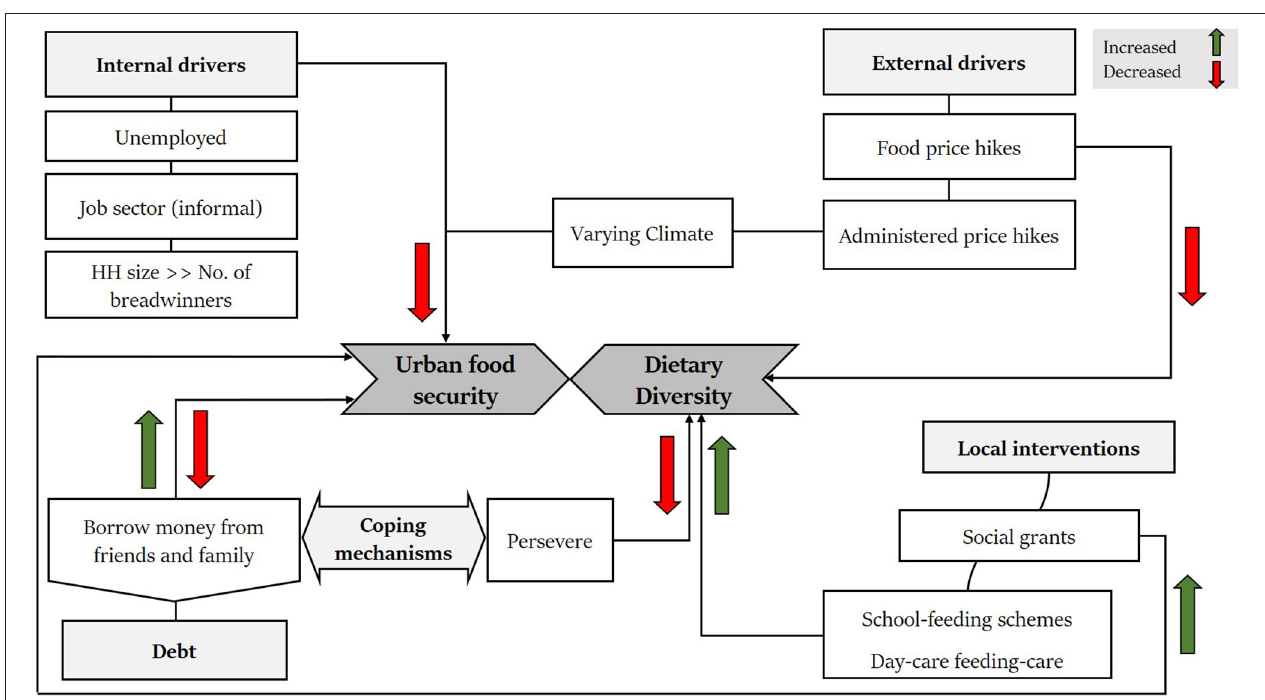
FIGURE 3 | This conceptual diagram illustrates the linkages between the drivers of urban food security and how they interact with each other in